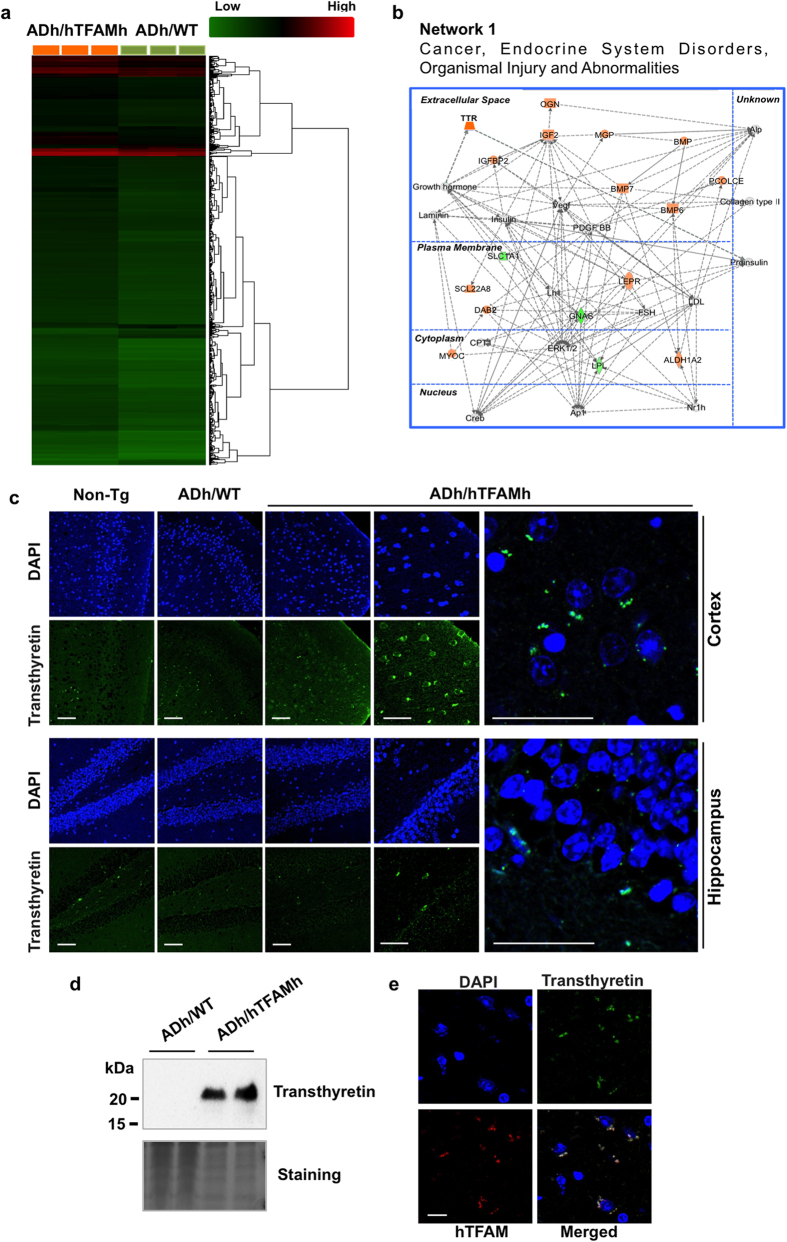
hTFAM markedly increases expression of a set of genes in ADh/WT mice.(a) Hierarchical portioning and clustering of 166 transcript clusters demonstrate 1.6-fold or greater difference between hippocampi from ADh/WT and ADh/hTFAMh mice. Student’s t-test p < 0.05, n = 3. (b) Top significant network. Solid and dashed lines indicate direct and indirect interactions, respectively. Molecular interactions involving only binding were excluded. Downregulated molecules are shown in green and upregulated molecules are shown in red. (c) hTFAM increases the level of transthyretin in ADh/WT mice. Scale bar, 20 μm. (d) Western blot analysis of extracts prepared from cerebral cortices using anti-transthyretin. Ponceau S staining was used as the loading control (lower panel). (e) Double-immunostaining with anti-human TFAM and anti-transthyretin in ADh/hTFAMh cortex. Scale bar, 20 μm.